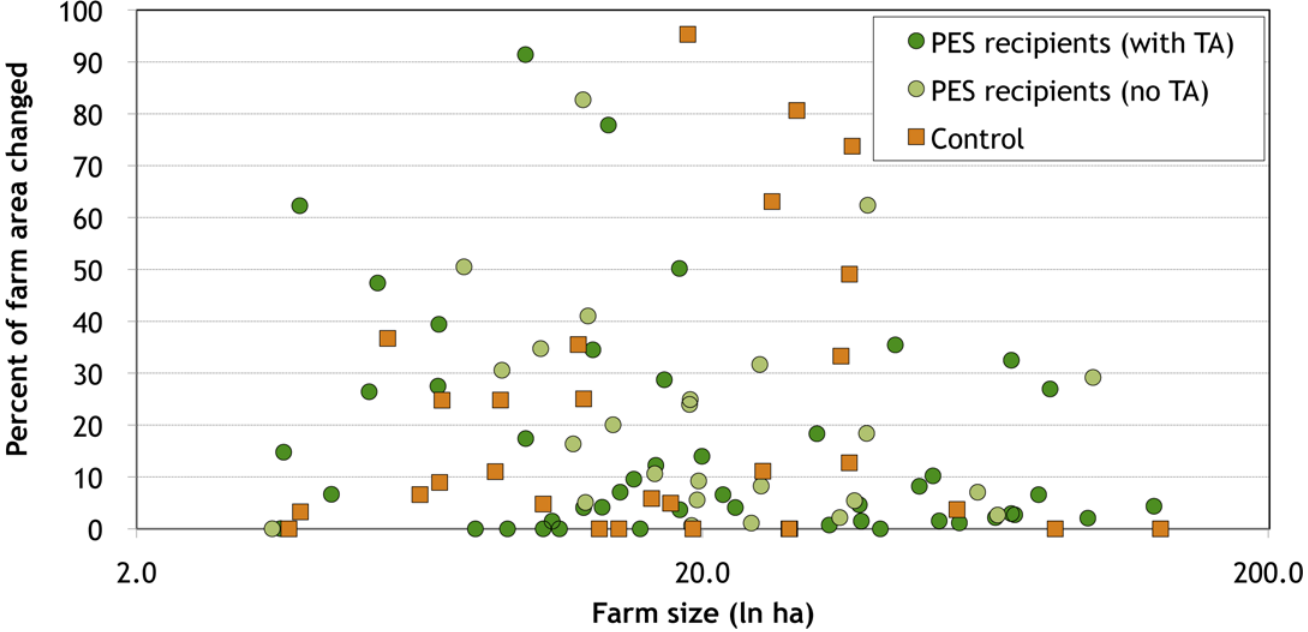
Fig 4. Post-PES land use changes in Quindío, Colombia, by farm